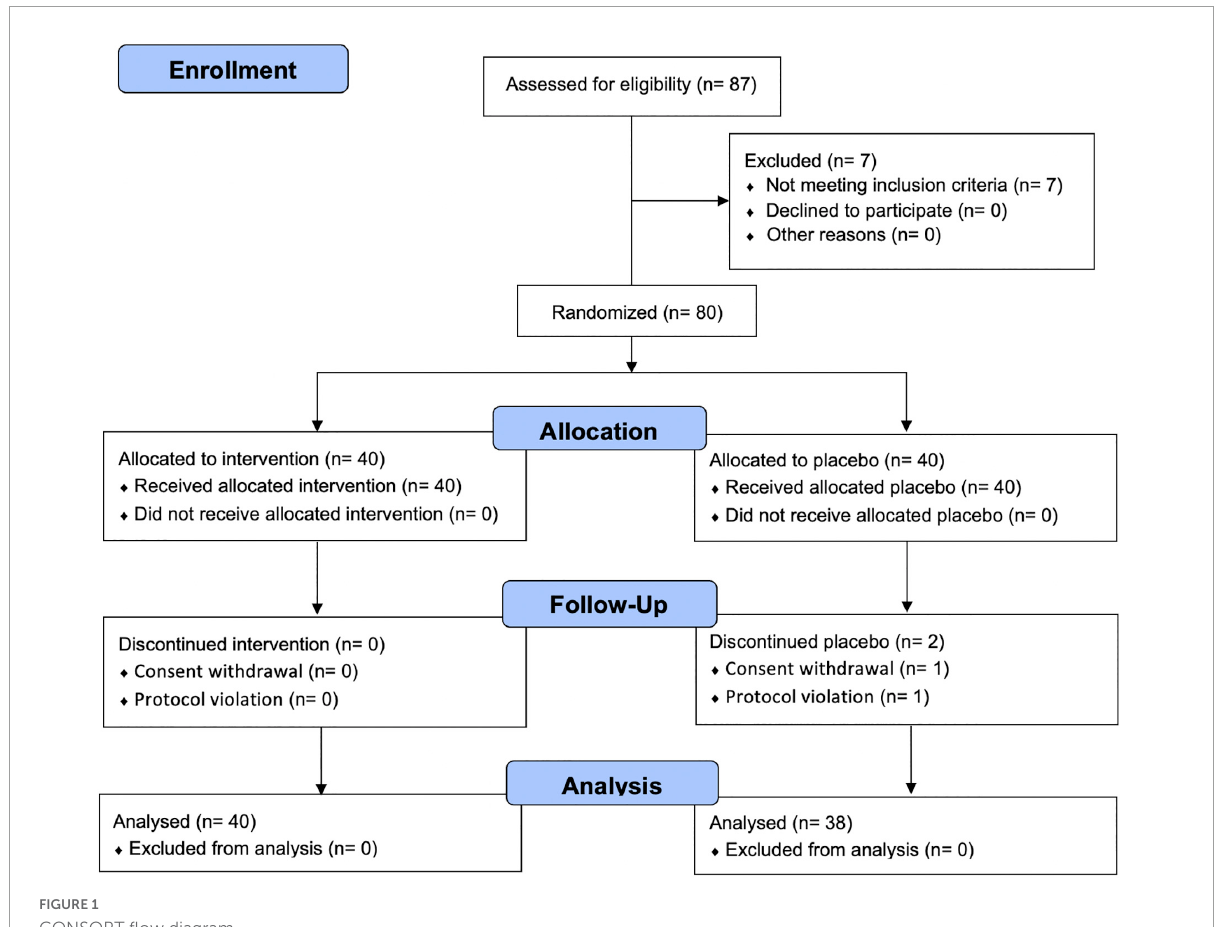
FIGURE1 CONSORT flow diagram.